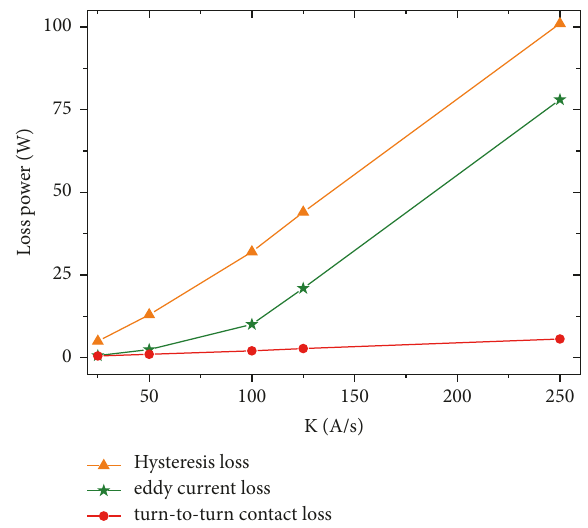
Figure 13: Loss dependence on K , with a constant I